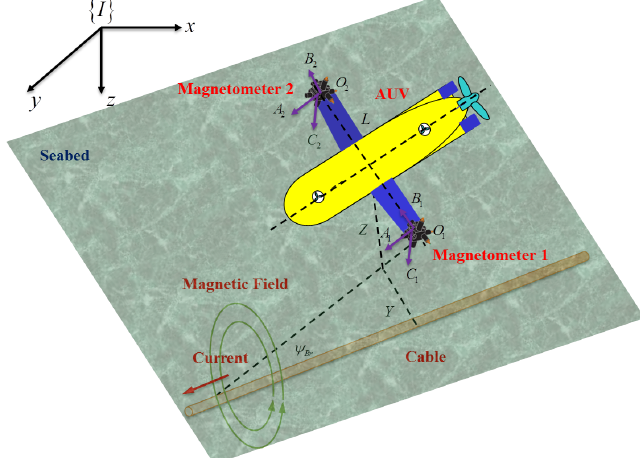
Figure 1. The yellow AUV equipped with two tri-axial magnetometers is tracking the orange cable. The induced electromotive forces in the x -axis, y -axis and z -axis of the tri-axial Magnetometer 1 and Magnetometer 2 are ( A 1 , B 1 , C 1 ) and ( A 2 , B 2 , C 2 ) , respectively. The distance between those two magnetometers is O 1 O 2 = L , and { I } is the inertial frame. In addition, ψ Br , Y and Z denote the heading deviation, horizontal offset and vertical distance between the AUV and the